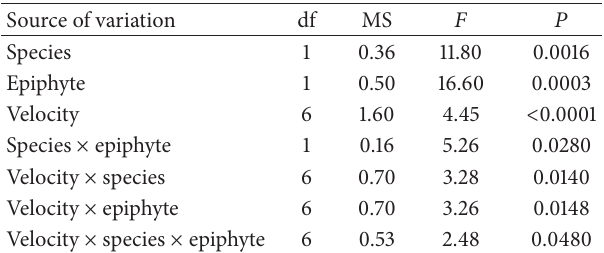
Table 1: RM-ANCOVA analysis of limpet drag forces per cm 2 of shell.